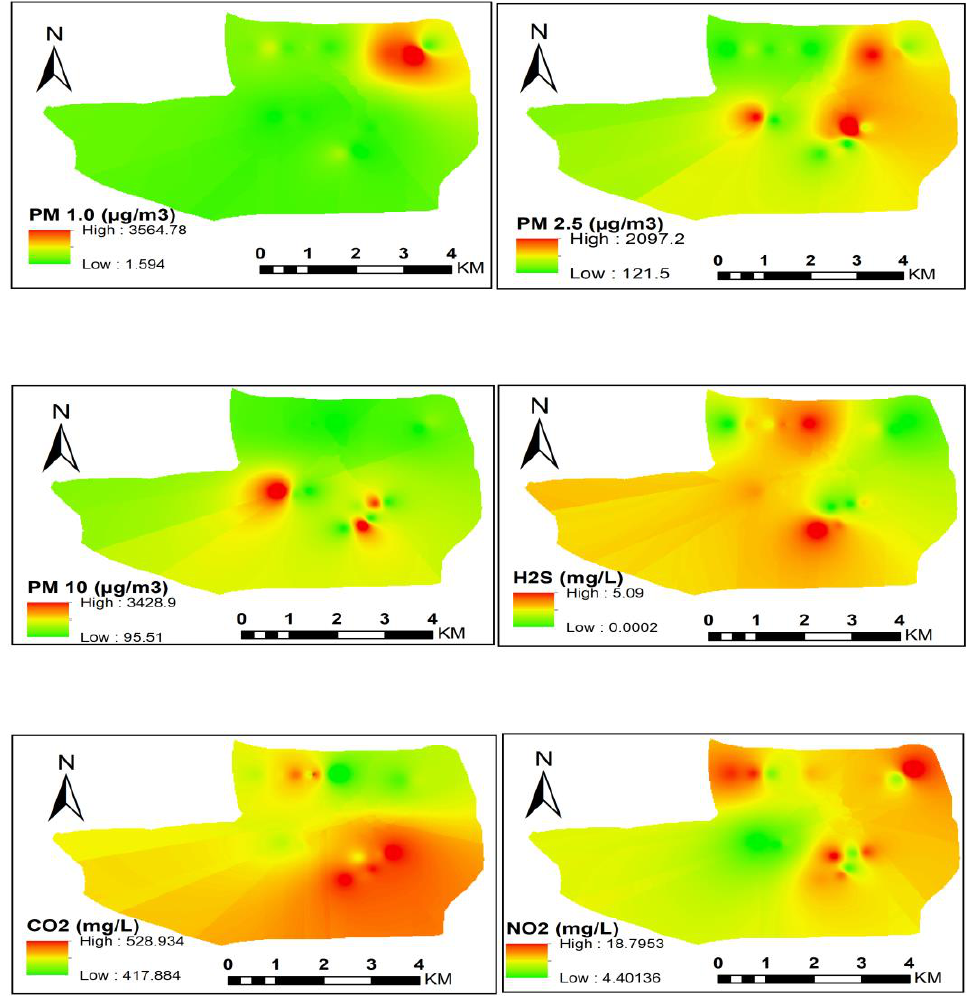
Figure 5. The concentration of particulate matter, H 2 S, CO 2 and NO 2 in the study area. Note: ( A ) PM1.0; ( B ) PM2.5; ( C ) H 2 S; ( D ) PM10; ( E ) CO 2 ; ( F ) NO 2